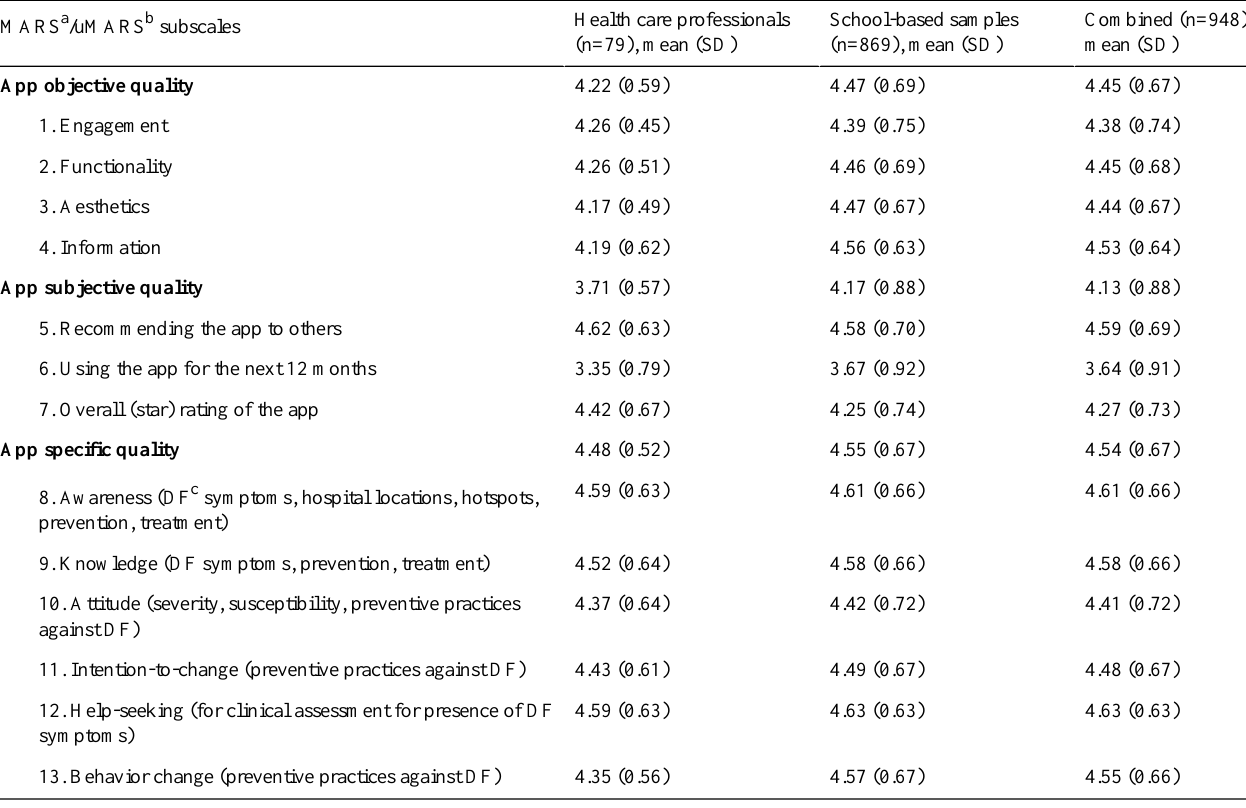
Table 2. Mean scores of app objective, subjective, and specific quality ratings based on the Mobile Application Rating Scale from health care professionals and school-based